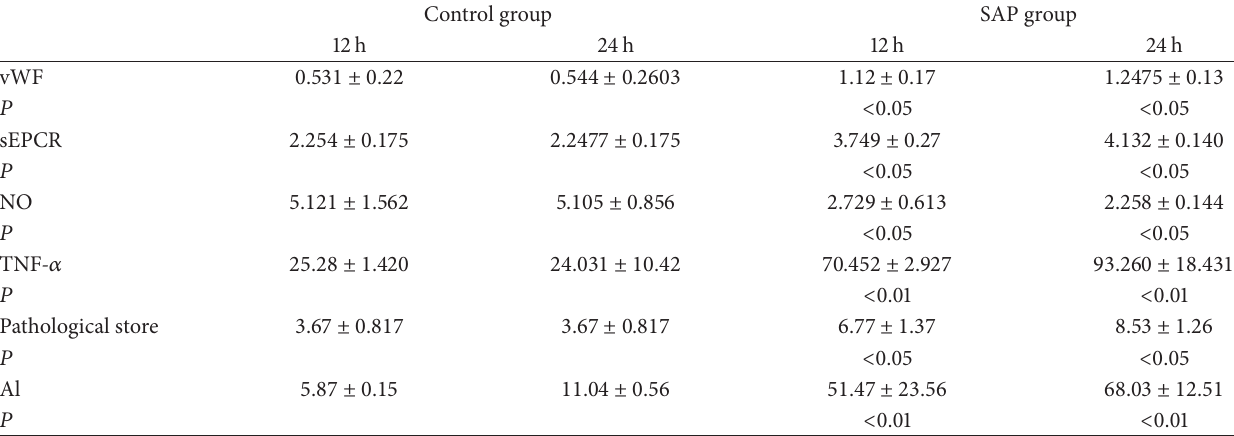
Table 2: Expression level of vWF, sEPCR, NO, and TNA- 𝛼